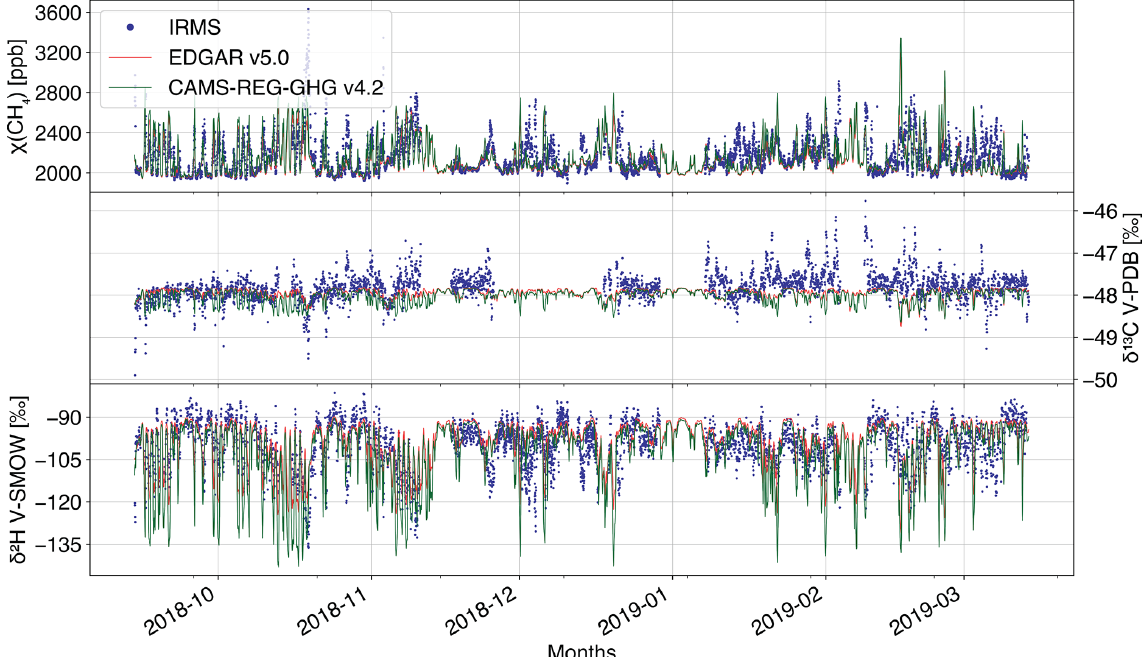
Figure 4. Time series of the observed (blue circles) and modelled χ (CH 4 ), δ 13 C and δ 2 H, based on the EDGAR v5.0 (red) and CAMS- REG-GHG v4.2 (green) inventories.